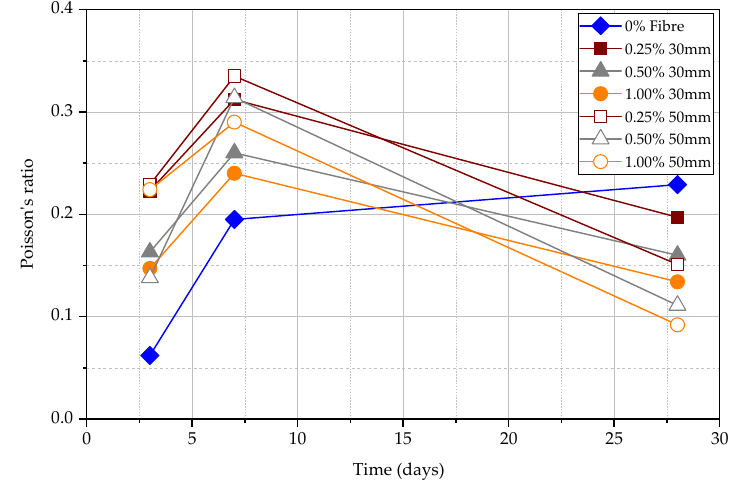
Figure 22. Poisson’s ratio of beams at 3, 7, and 28 days.